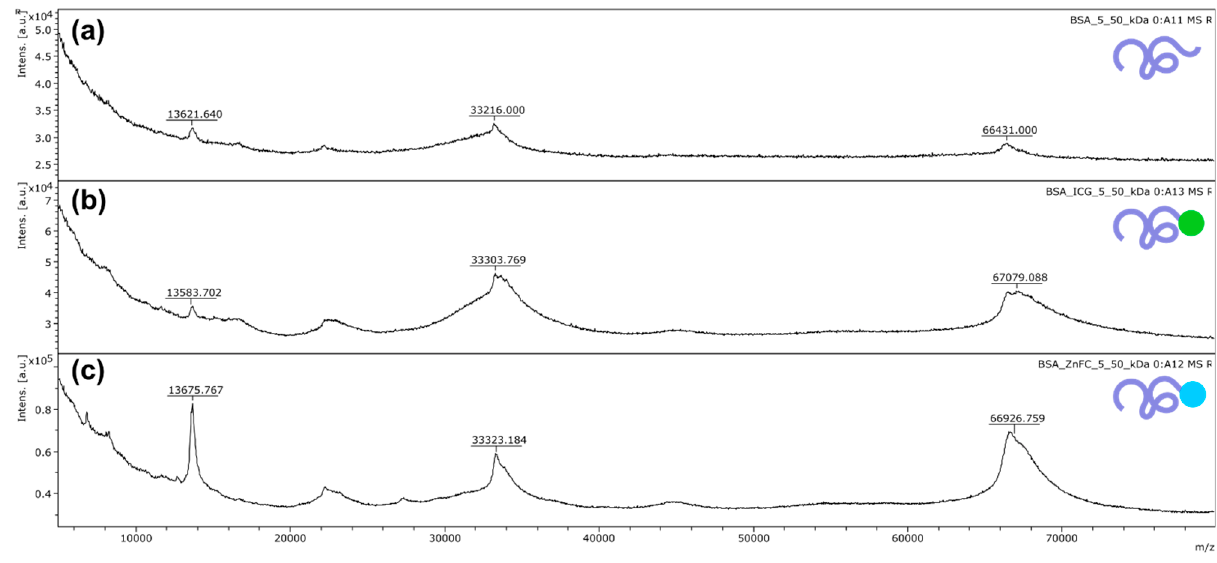
Figure 2. Mass spectrometry measurements for ( a ) BSA aqueous solution, ( b ) BSA-ICG conjugate aqueous solution, and ( c ) BSA-ZnPc conjugate aqueous solution were carried out to confirm the covalent binding of BSA-ICG and BSA-ZnPc conjugates.